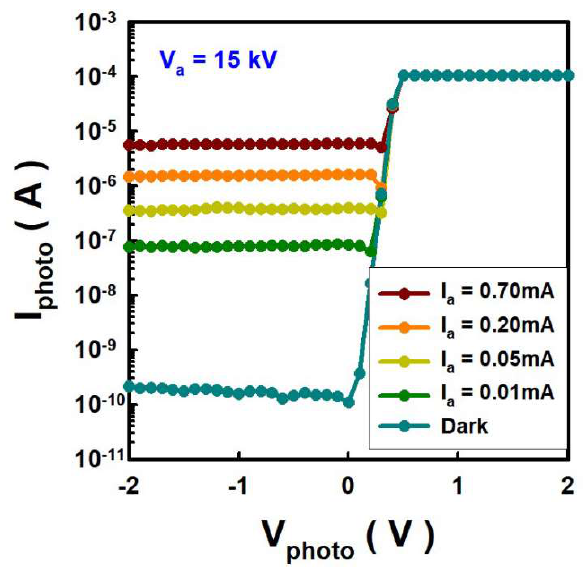
Figure 5. The anode voltage is fixed at 15 kV, and the photocurrent increases as the anode current increases.